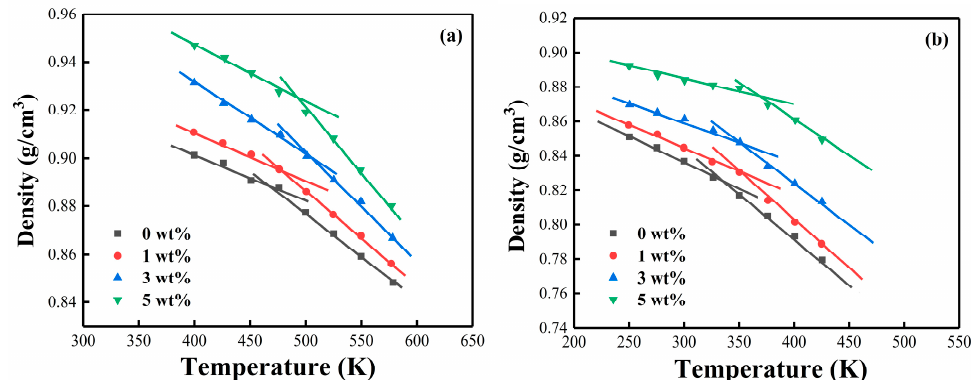
Figure 11. DSC curves of ( a ) PNE-177/DDS and ( b ) PNE-177/DICY systems at the heating rate of 5 °C/min.